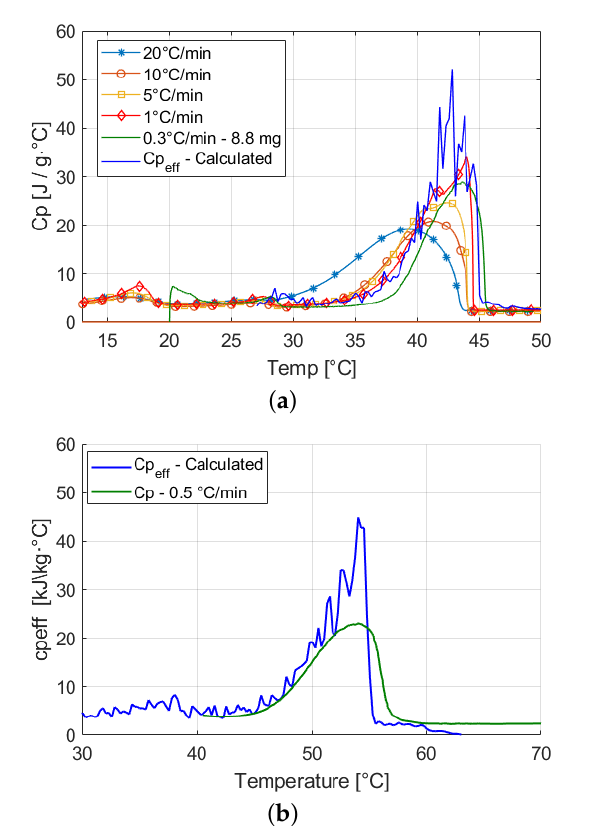
Figure 18. (Comparison of cp results between the c p , ef f and the DSC method ( a )) RT45; ( b )